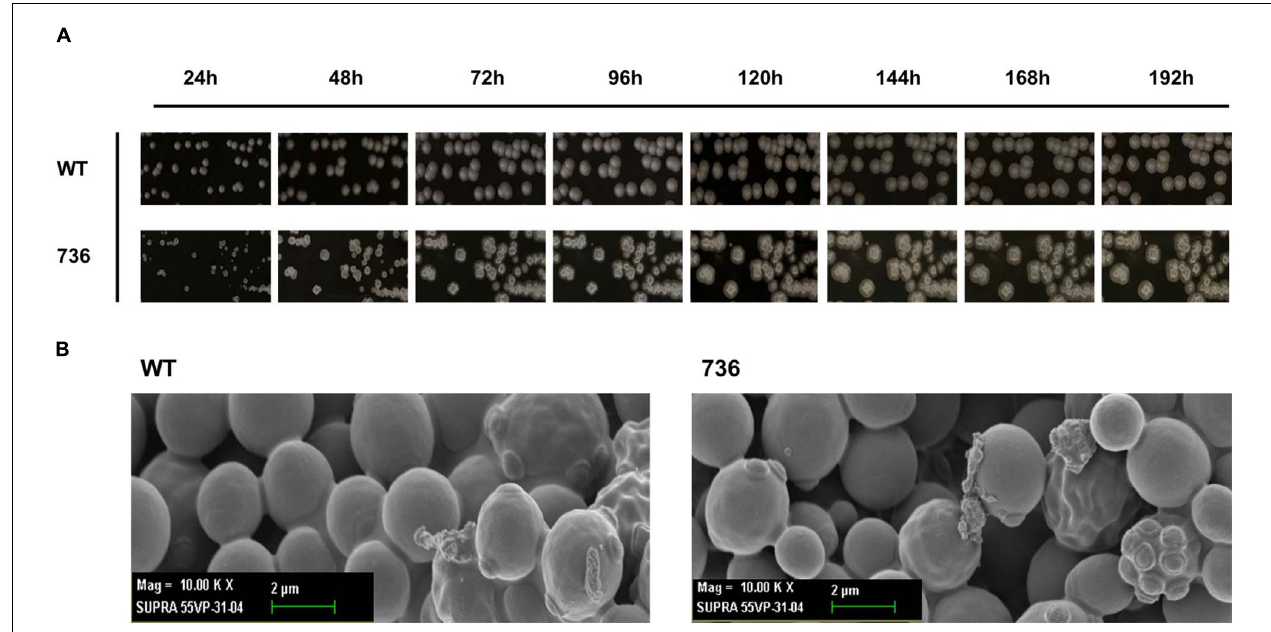
FIGURE 2 | Morphological changes in the wild-type and mutant 736 on agar plates and scanning electron micrographs. (A) Morphological changes in the wild type (indicated as WT) and mutant 736 (indicated as 736) on YPD agar plates were periodically compared for 192 h. (B) A scanning electron micrograph of the wild-type (left) and mutant 736